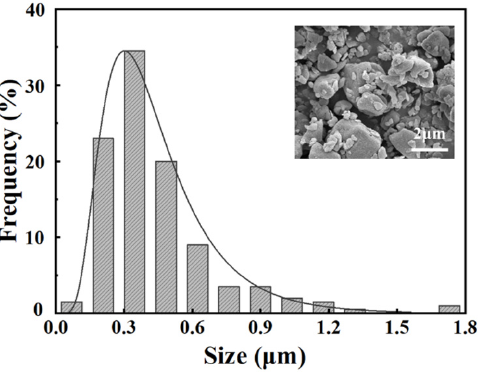
Figure 1. The size distribution and morphology of the nano-glass powder.